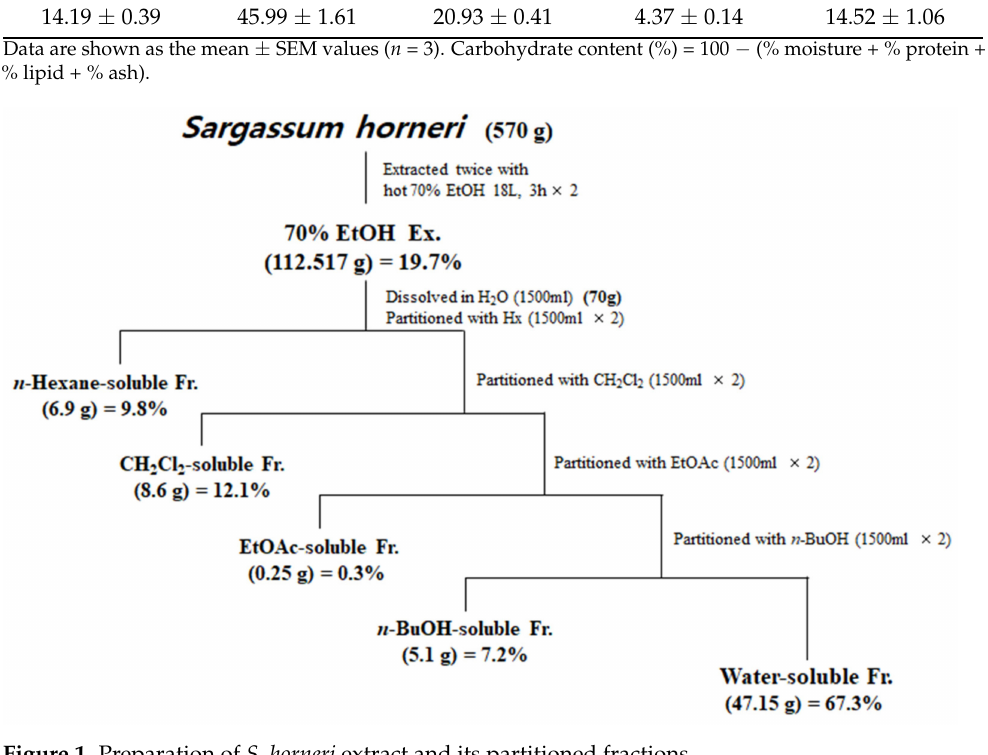
Figure 1. Preparation of S. horneri extract and its partitioned fractions. Table 2. The monosaccharide composition analysis of 70% EtOH extract of S. horneri and its CH 2 Cl 2 - and water-soluble fractions. n.a.*: not applicable